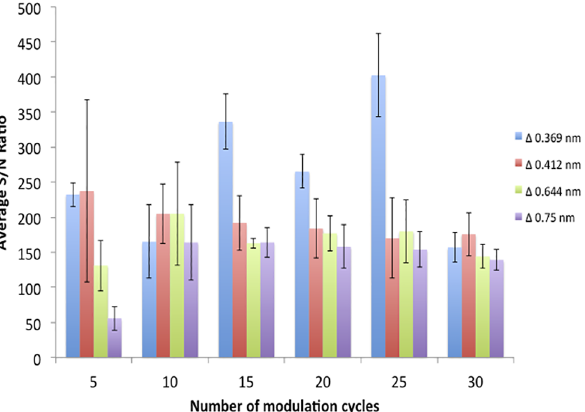
Fig 1. WMRS measurements of the signal to noise ratio (S/N) of the cellulose band at 1089 cm -1 . Bar chart shown represents measurements of the S/N using a 4s exposure time whilst varying the number of kinetic cycles and band-to-band voltage. Error bars shown are the standard deviation of 5